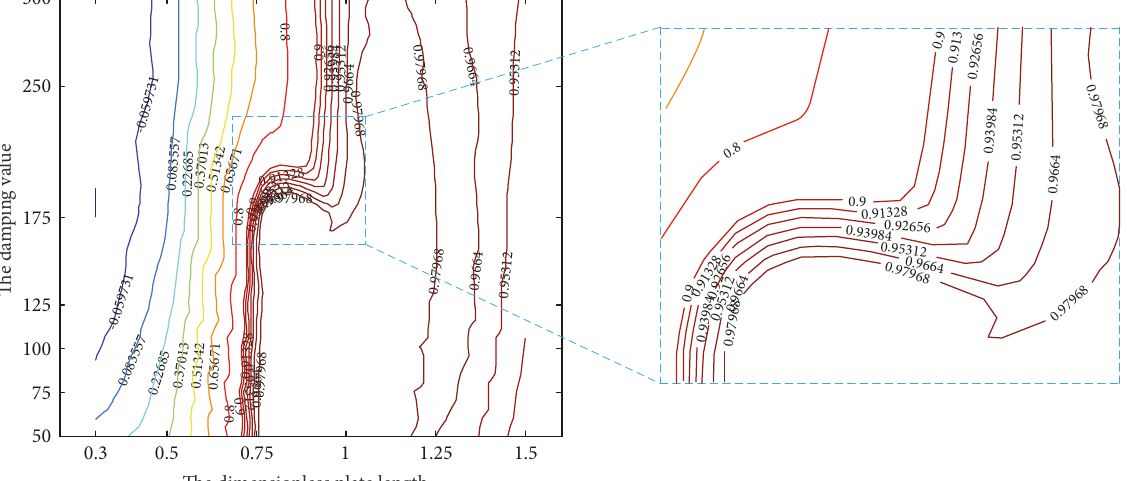
Figure 11: Two-dimensional contour line of variation of the vibration suppression rate.